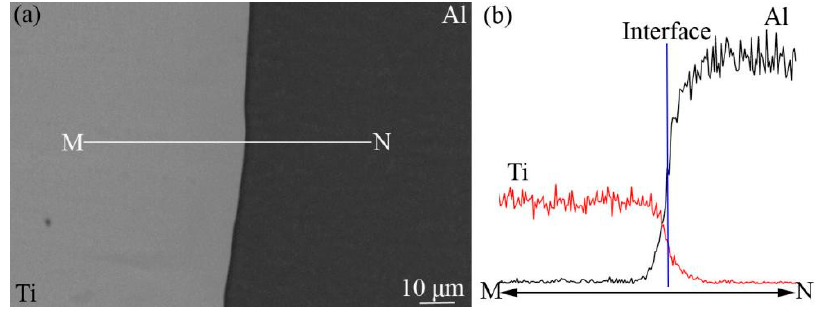
Figure 1. Typical SEM images after welding ( a ) and EDX results ( b ).